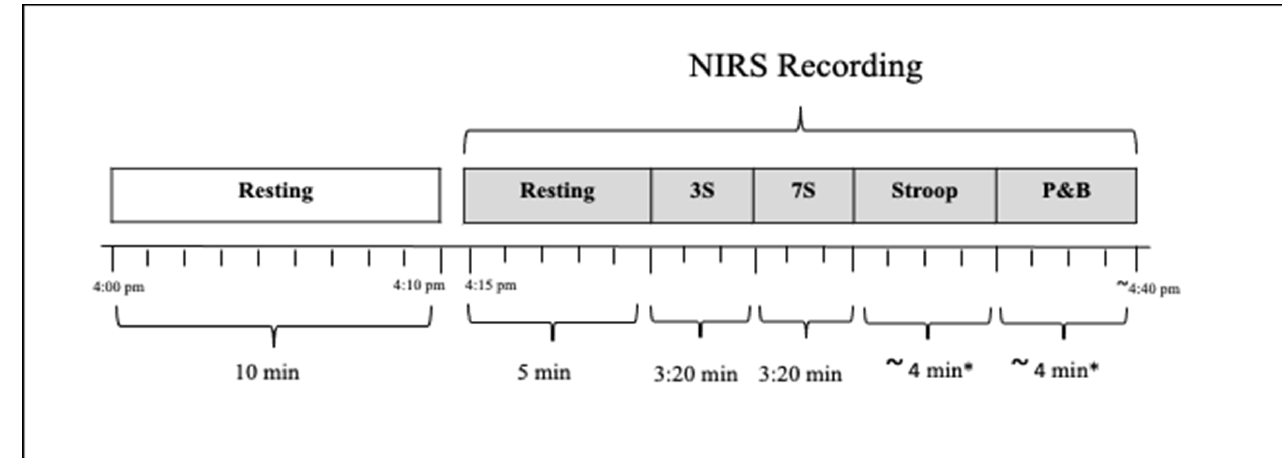
Figure 2. Protocol of the near-infrared spectroscopy (NIRS) assessment; 3S: serial subtraction 3, 7S: serial subtraction 7, P&B: peg and ball. * Stroop and peg and ball are not based on a fixed time, so the data were extracted based on the least time recorded by a participant.